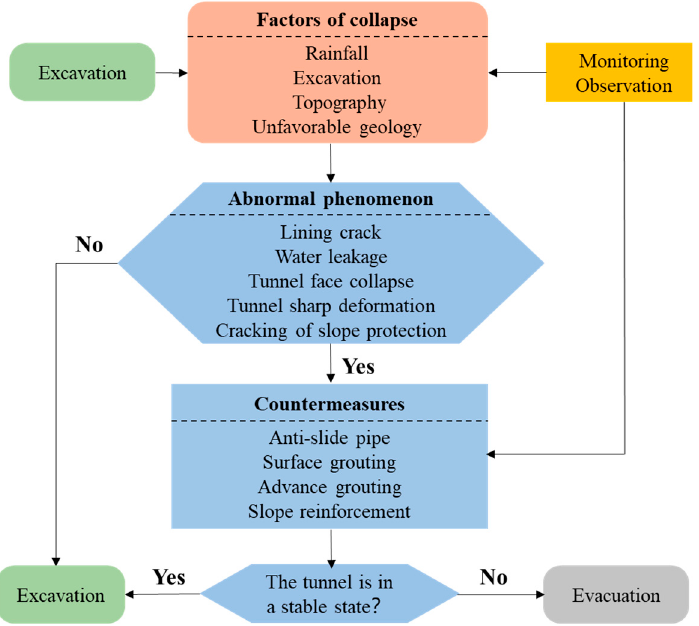
Figure 15. Prevention and treatment process of tunnel entrance collapse under rainfall